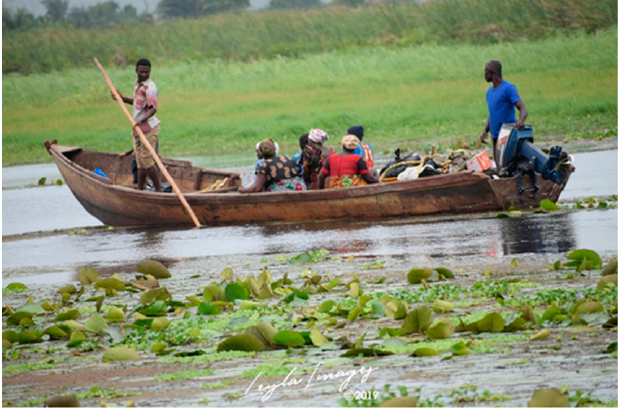
Figure 3. Aquatic weeds hamper users of the Volta River at Kpong downstream of the Volta Dam. Credit: Krobo Land.